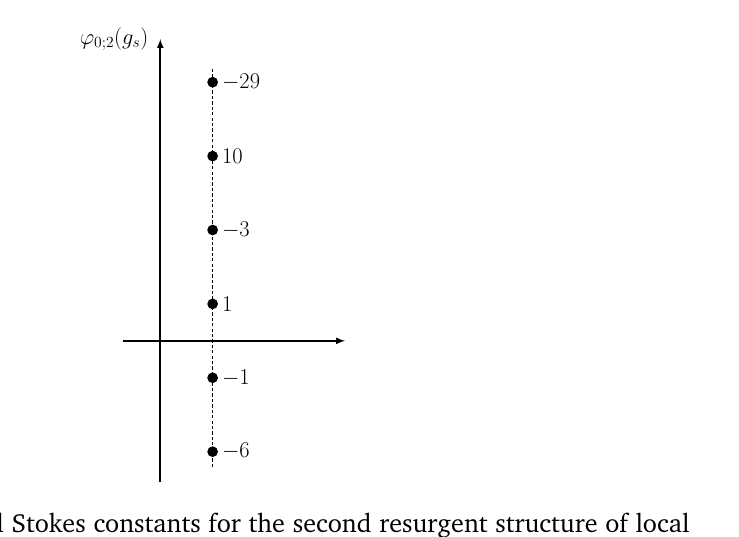
Figure 11: Off-diagonal Stokes constants for the second resurgent structure of local (cid:80) 2